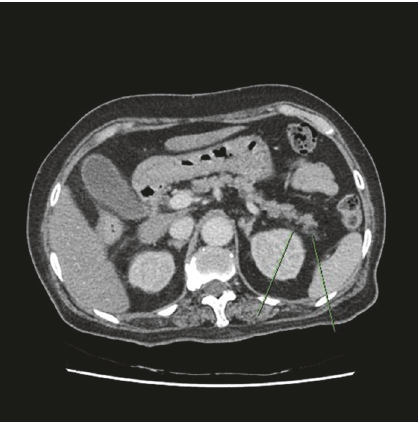
Figure 1: Abdominal computer tomography (CT) scan shows acute pancreatitis. Contrast enhanced abdominal CT scan shows fat infiltration in the tail portion of the pancreas parenchyma, suggesting acute pancreatitis grade C.